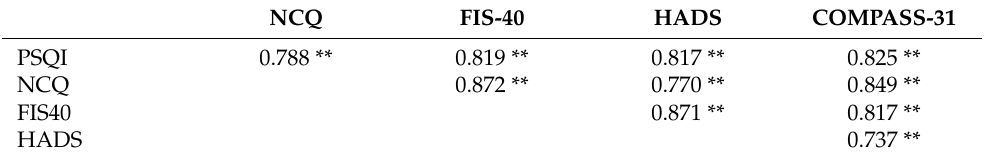
Table 4. Pearson correlations between global questionnaire scores for the total sample ( n = 51